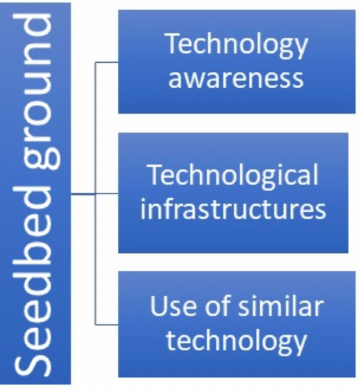
Figure 1. Seedbed ground for the acceptance of new